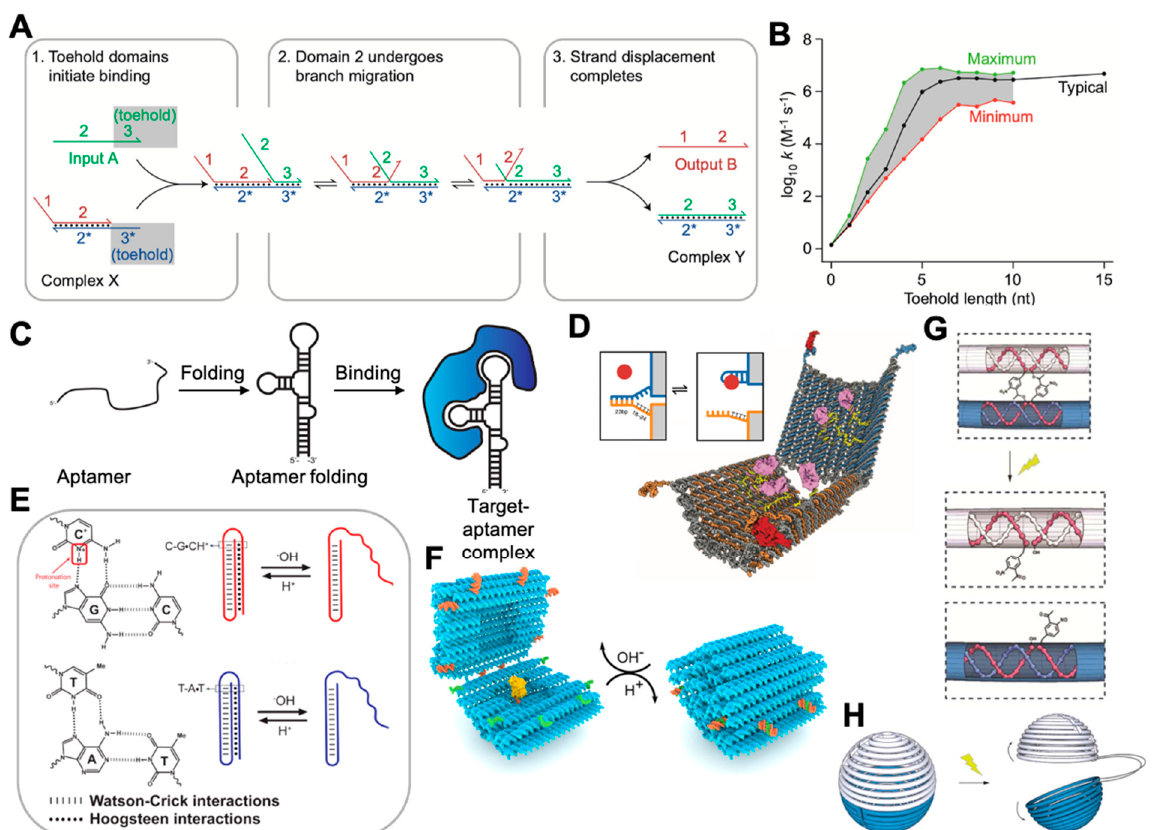
Figure 2. Dynamic DNA nanotechnology and its application in constructing dynamic devices. ( A ) An example of TMSD, adapted with permission from [90]. ( B ) The kinetics of TMSD can be tuned by changing the length and sequence of the toehold domain, adapted with permission from [90]. ( C ) Schematic representation of aptamer binding to a target protein, reproduced from [91] under terms of the CC BY 4.0 license. ( D ) An DNA nanorobot that can be opened by receptor-induced binding with aptamers, adapted with permission from [71]. ( E ) pH-triggered nanoswitches that form an intramolecular triplex structure through the formation of a Watson–Crick (dashed) pH-insensitive hairpin and a second Hoogsteen (dots) pH-sensitive hairpin, adapted with permission from [80]. ( F ) Hoogsteen base-pairing-based box that closes in low-pH conditions, adapted from [75] under the terms of the Creative Commons CC BY license. ( G , H ) Ortho-nitrobenzyl functionalized DNA capsule that opens upon exposure to light, adapted with permission from [81] .